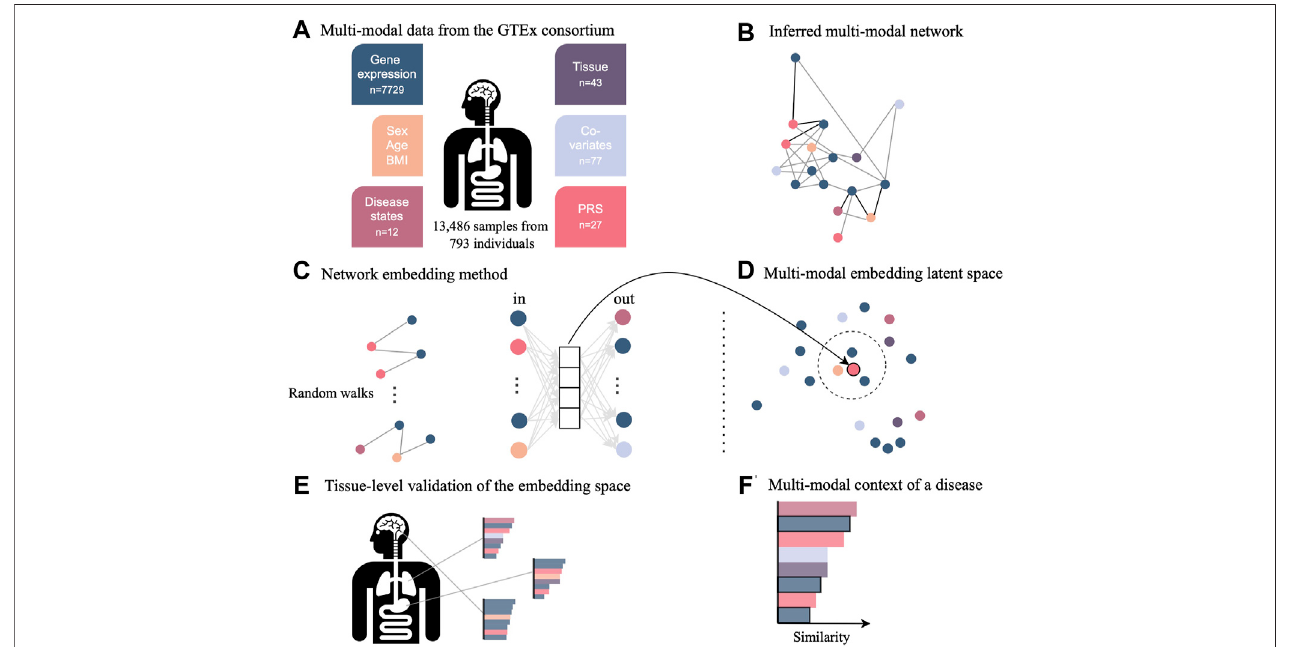
FIGURE1| Novelnetworkinferenceandembeddingframeworktointegratemultimodaldatafortheinvestigationinlow-dimensionalspace. (A) DatafromtheGTEx consortium consisted of gene expression across multiple tissues, phenotypes such as sex and age, diagnosis, technical and biological covariates, as well as polygenic riskscores(PRS)representingthegeneticpredispositionforacertaindisease. (B) Multimodaldataintegrationwascarriedoutwiththenetworkinferencemethodnamed KiMONo to obtain a multimodal multi-tissue network. (C) Resulting network was embedded into a low-dimensional space using a method adapted from GeneWalk, which uses the results of random walks of sequentially visited nodes. (D) Weights of the hidden layer are the embeddings and were explored using cosine similarityscoresto (E) validatetheembeddingspaceusingtissue-speci fi cgenesand (F) understandthemultimodalcontextofgenesessentialtoCOVID-19,whichhave been identi fi ed previously by external